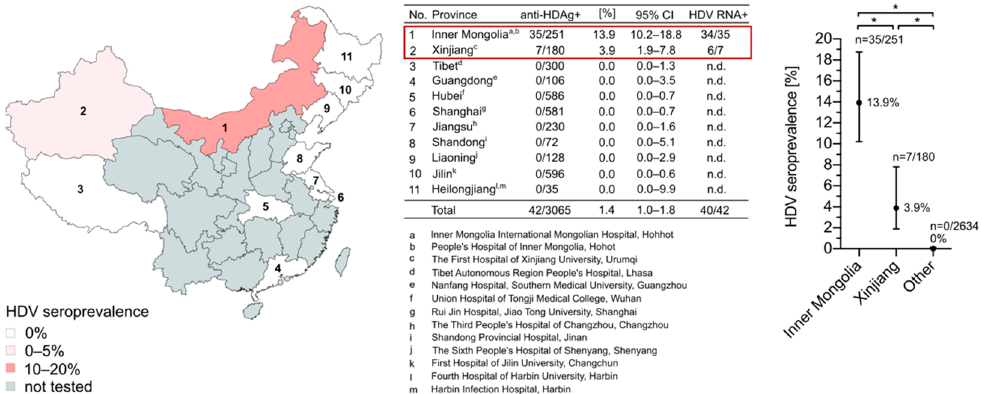
Figure 1. Geographic distribution of the HDV seroprevalence in China. Serum samples were collected from HBsAg-positive patients living in seven provinces (Liaoning, Shandong, Jilin, Heilongjiang, Guangdong, Jiangsu, and Hubei), three autonomous regions (Inner Mongolia, Xinjiang, and Tibet), and one municipality (Shanghai). All sera were tested for anti-HDV-Ab using the HDV rapid test. CIs of 95% were calculated according to the Wilson score interval and seroprevalences were compared using the Chi-squared test. * corresponds to a p -value < 0.05.